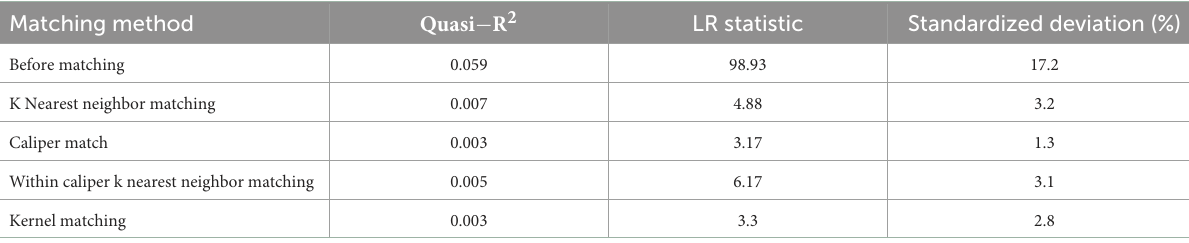
TABLE 6 Results of balance tests before and after matching of followership behavior explanatory